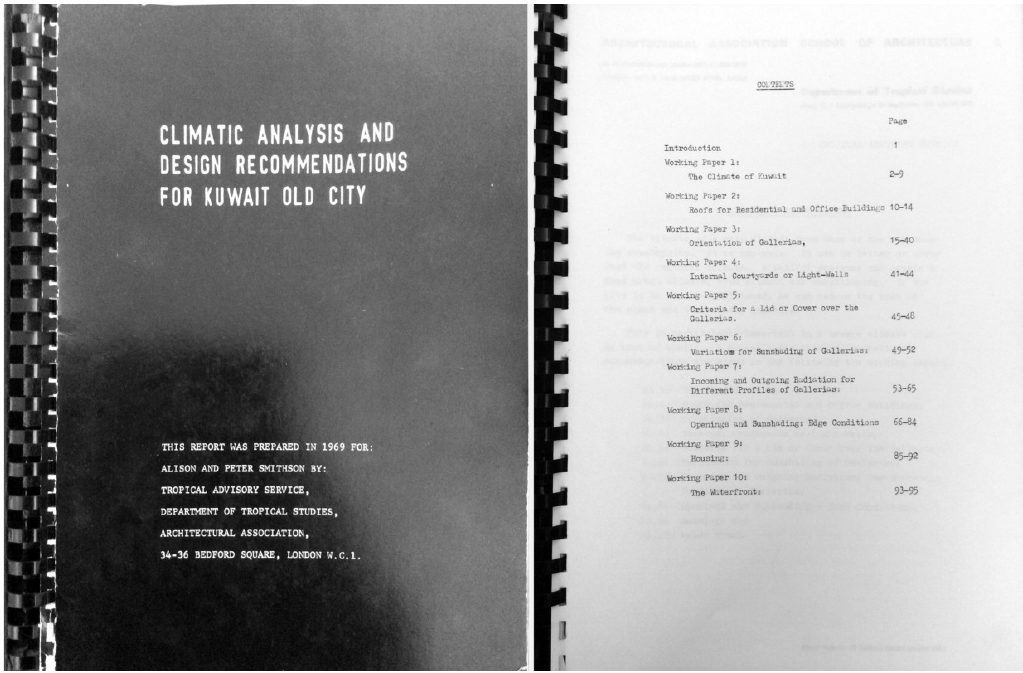
Figure 10. Climatic Analysis and Design Recommendations for Kuwait Old City : Report prepared in 1969 for Alison and Peter Smithson by the TAS. Source: Koenigsberger